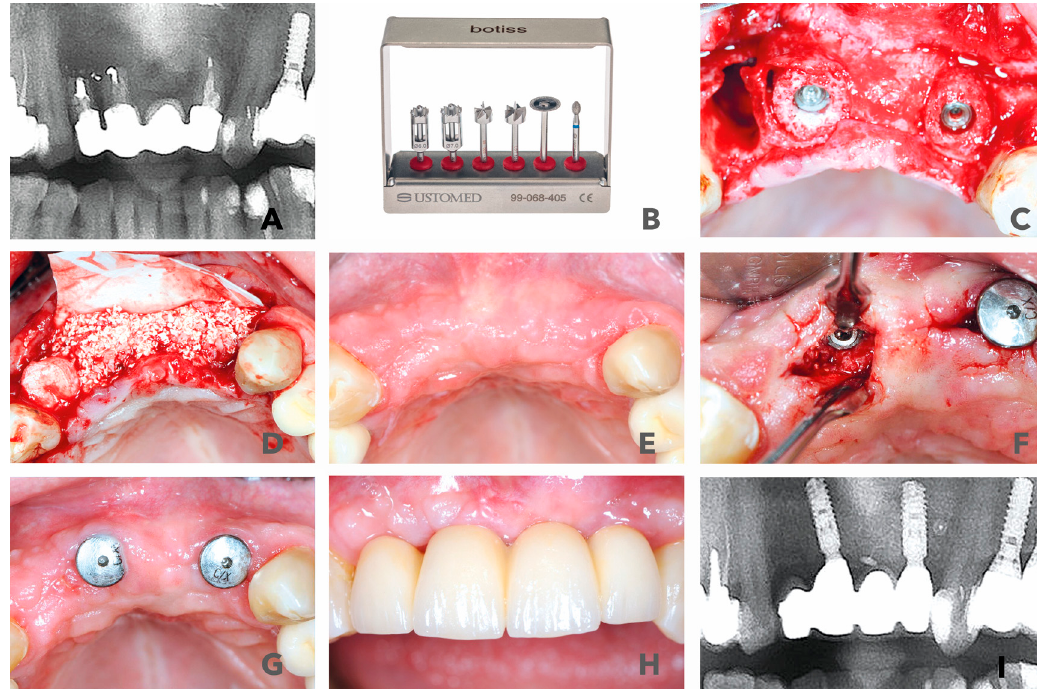
Figure 2. ( A ) Radiological display of the bone defect in frontal maxilla #11-22. ( B ) maxgraft bonering surgical kit. ( C ) Bone augmentation with two cylindrical FDBAs and fixation with dental implants. ( D ) Augmentation site contoured with bovine bone substiute and covered with collagen membrane. ( E ) and ( F ) Six-month follow-up of contouring and re-entry to place gingiva formers. ( G ) and ( H ) Integration of prosthetic restoration 6 weeks after re-entry and 7.5 months after initial surgery. ( I ) Thirty-six-month radiological follow-up showed stable bone in augmented area.